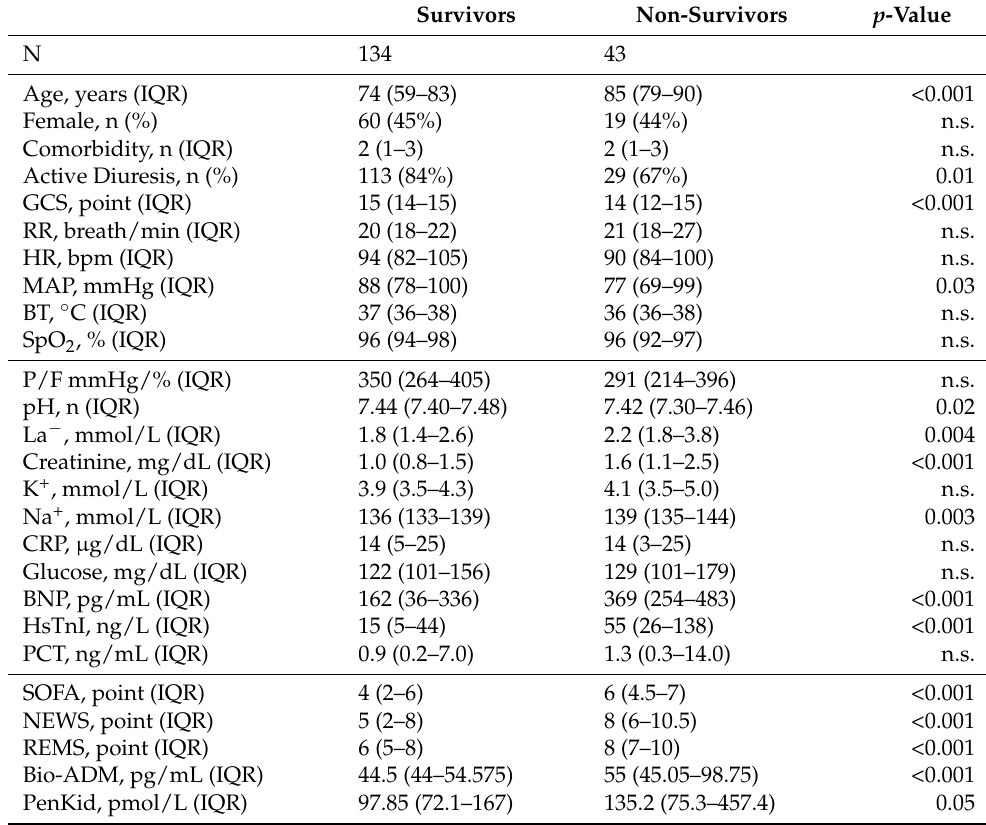
Table 2. Comparison between survivor and non-survivor